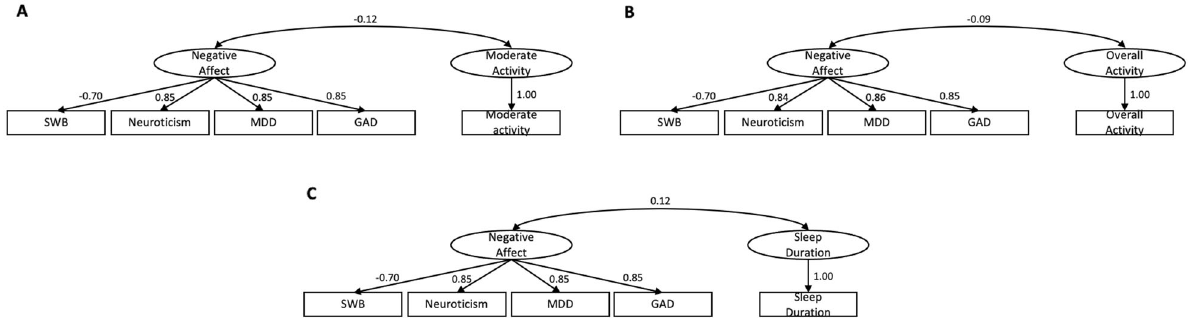
Fig. 4 Genetic correlations between negative affect and physical activity phenotypes. Signi fi cant genetic correlations with negative affect were observed for moderate ( A ), overall activities ( B ), and sleep duration ( C ). The latent negative affect factor loaded positively on neuroticism, major depression disorder (MDD), and general anxiety disorder (GAD) phenotypes, but negatively on the subjective well-being (SWB)